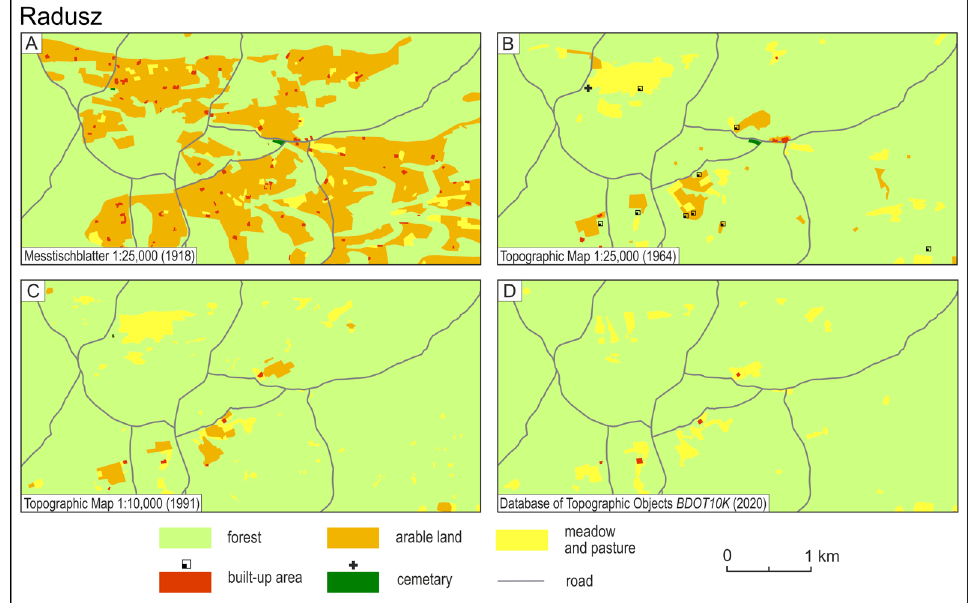
Fig. 7. Land use changes in the vicinity of the village of